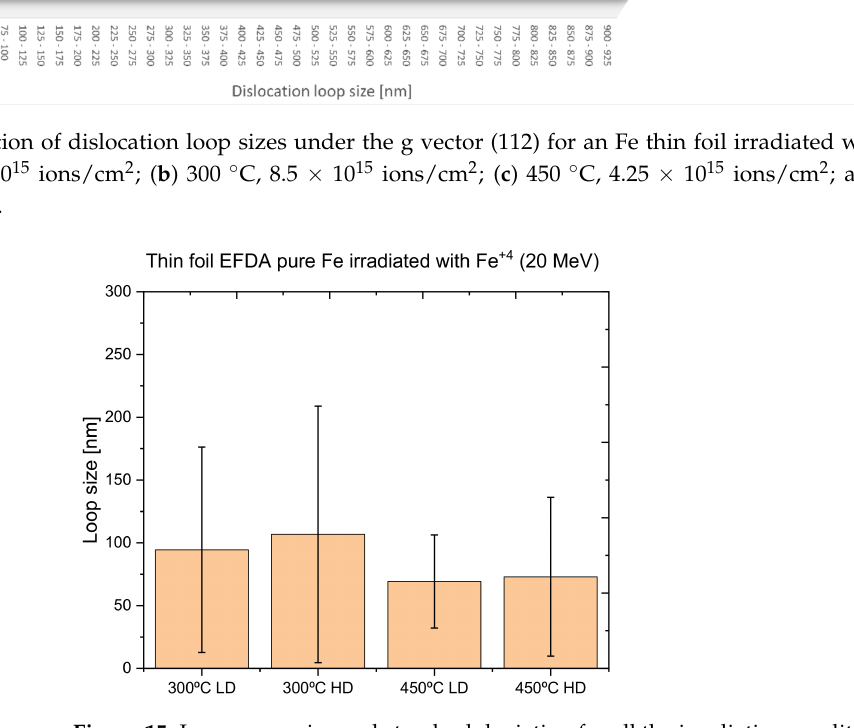
Figure 15. Loop mean size and standard deviation for all the irradiation